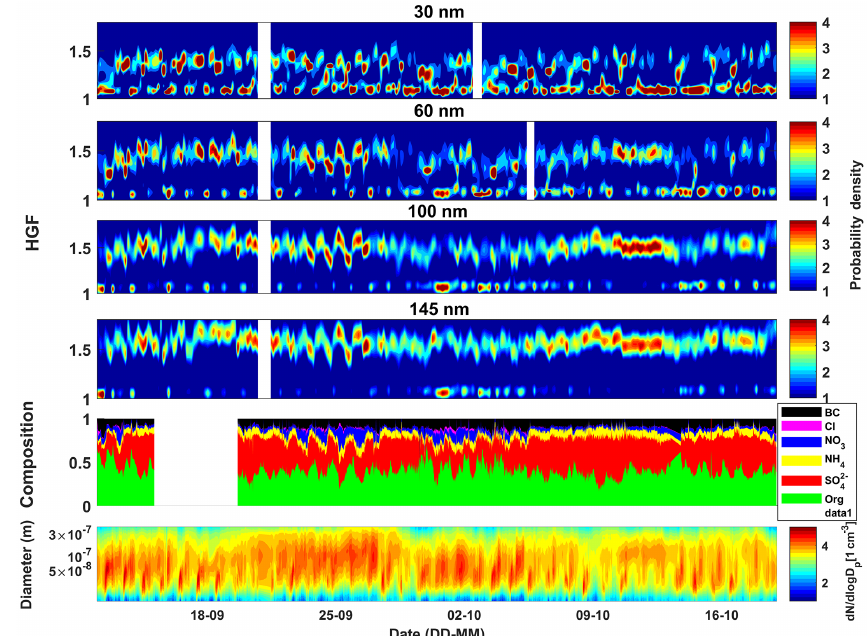
Figure 2. Time series of hygroscopic growth factor distribution for 30, 60, 100 and 145nm particles using HTDMA in the upper four panels and with the color code indicating probability density. Time series of mass fractions of chemical species in submicron particles and particle number size distribution within 10–400nm using ACSM and DMPS, respectively, in the lower two panels.